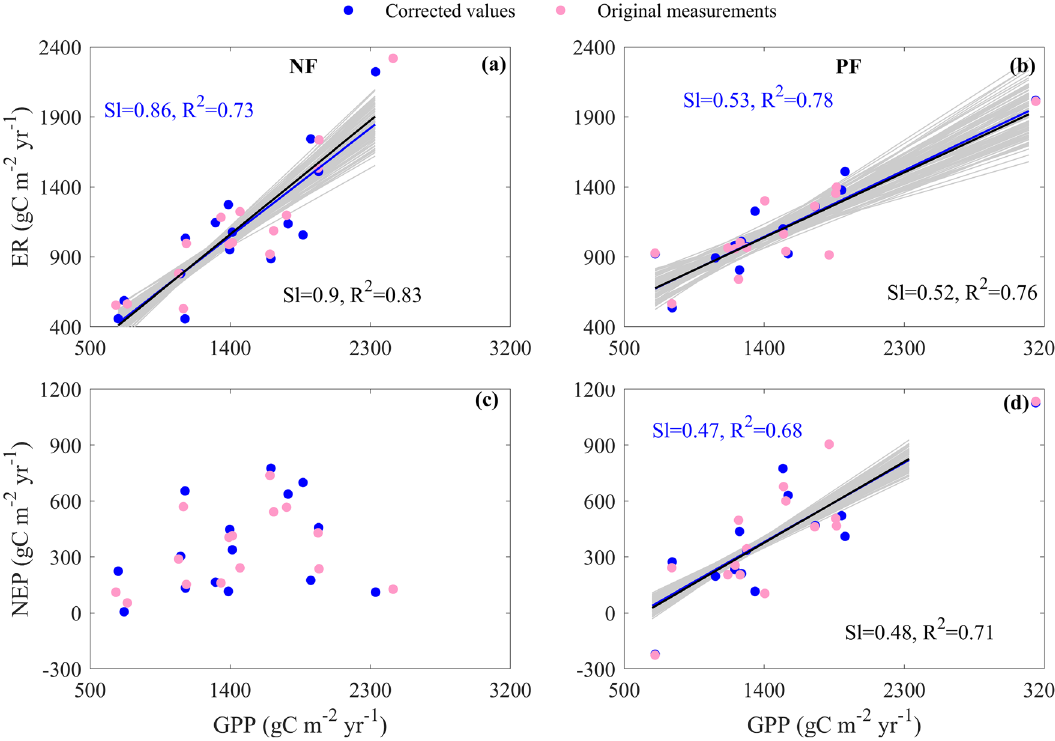
Figure 5. The spatial couplings between carbon fluxes over Chinese naturally regenerating forests (NF) and planted forests (PF). The spatial couplings include the coupling between gross primary productivity (GPP) and ecosystem respiration (ER) ( a , b ) and that between GPP and net ecosystem productivity (NEP) ( c , d ). Each panel is drawn with the corrected values (blue points) and original measurements (pink points), respectively. The blue and black lines represent the regression lines calculated from the corrected values and original measurements, respectively, with their regression statistics listed in blue and black letters. Only the regression slope (Sl) and R 2 of each regression are listed. The grey lines represent the regressions between carbon fluxes added by random errors and latitude. Only significant (p < 0.05) regression lines are drew in each